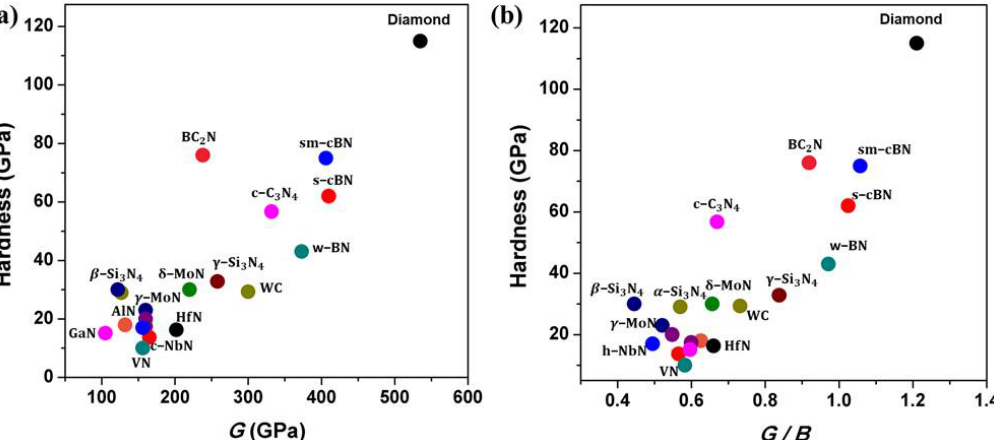
Figure 13. Correlation of experimental hardness for diamond, tungsten carbide, and some nitrides with ( a ) the shear modulus, G , and ( b ) G / B , where B is the bulk modulus, for 21 compounds (see Table 1); moduli of cubic C 3 N 4 and wurtzite boron nitride (w-BN) are from theoretical calculations.